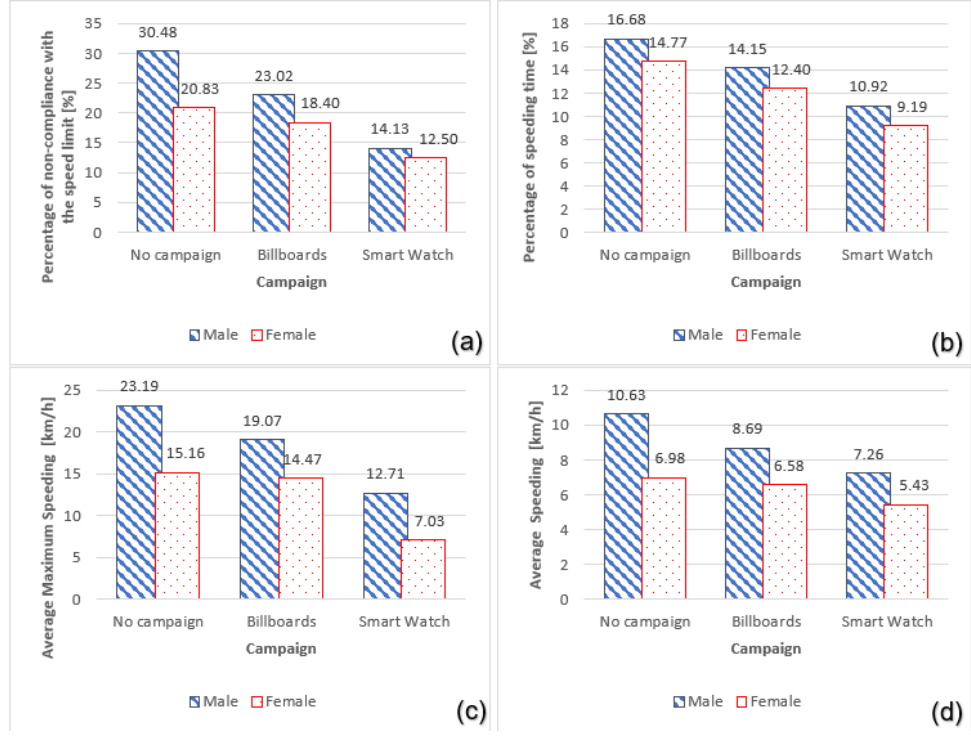
Figure 3. Results by gender for: ( a ) PncSL; ( b ) PST; ( c ) AMS; and ( d ) AS.